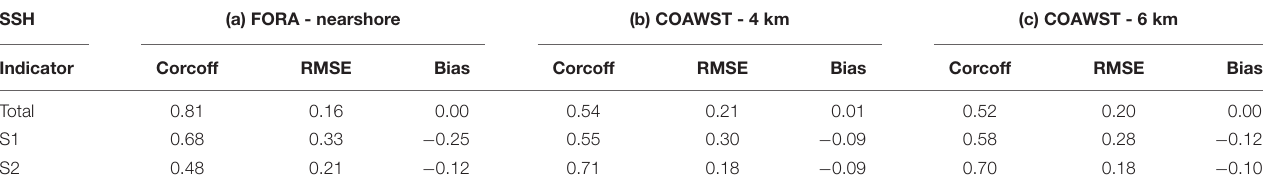
FIGURE 3 | Comparison of time series of Sea Surface Height among modeled and observed data in Choshi [(a,b): COAWST model 4 and 6 km eastward (2nd and 3rd grids) offshore, respectively, for domain 1; (c,d): COAWST model 4 and 6 km eastward (6th and 9th grids) offshore, respectively, for domain 2; (e) FORA model nearshore; (f): JMA observed data]. TABLE 1 | Correlation coefficient, RMSE and bias of (a) FORA nearshore and COAWST (domain 2) modeled runs at (b) 4 and (c) 6 km eastward offshore from Choshi for the total analyzed period, S1 and